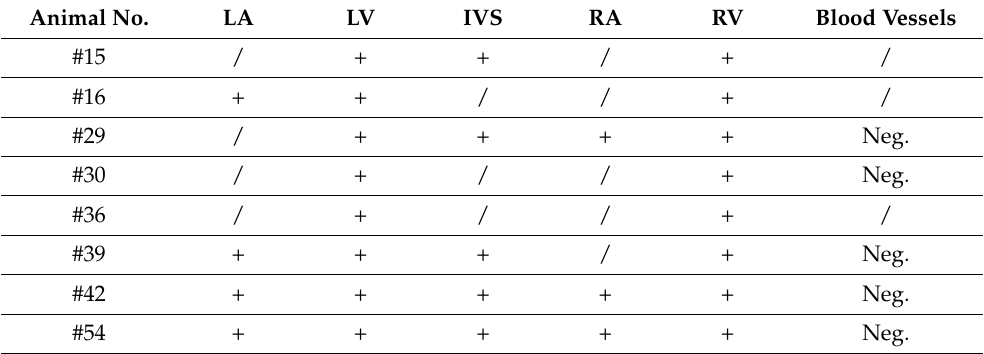
Table 1. Summaries of LacZ-positive signals of heart tissues in F1A-CreER T2 /ROSA26 mice. Animal No.